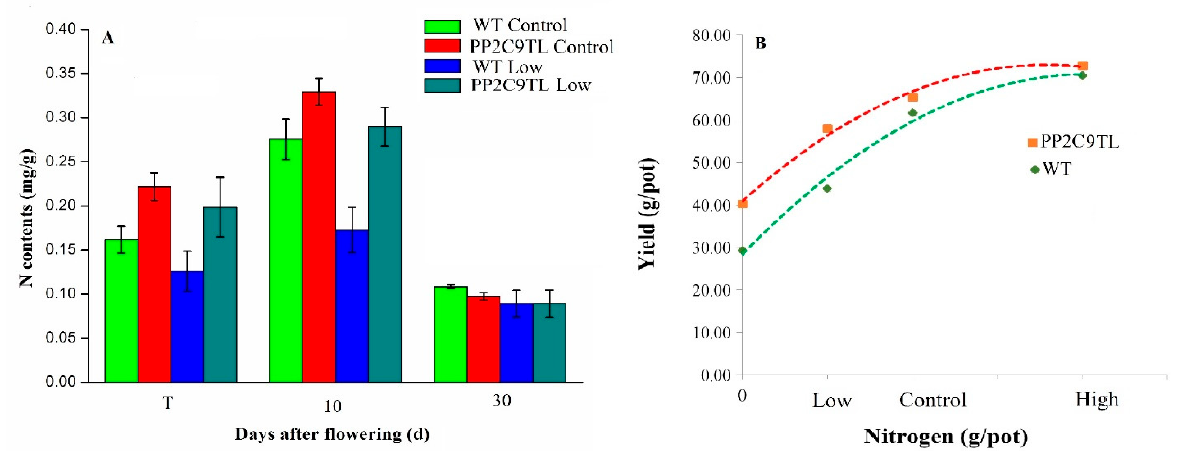
Figure 2. ( A ) The leaf N contents of PP2C9TL and WT at tillering T, 10 DAF, and 30 DAF; ( B ) the NUE of WT and PP2C9TL at low, control, and high levels of N.